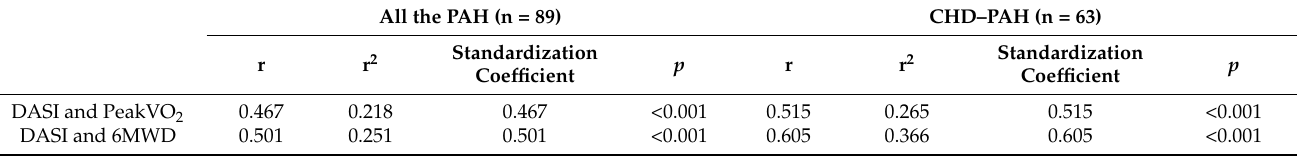
Table 2. Standardized coefficients of unary linear regression models for DASI to predict peak VO 2 (mL/kg/min) and 6MWD